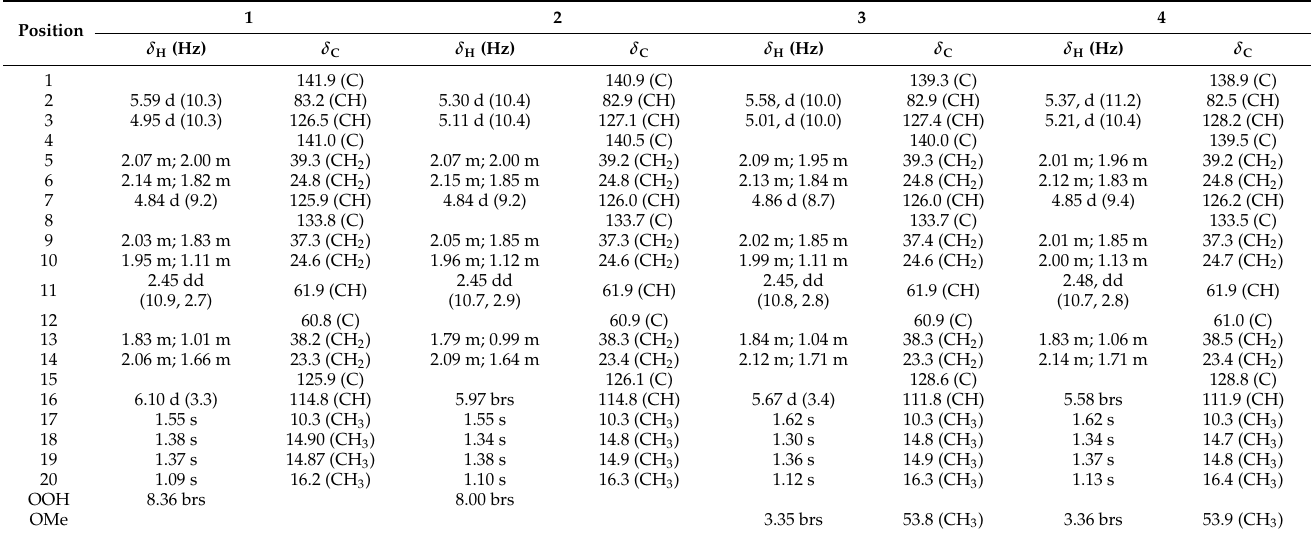
Table 1. 1 H (400 MHz) and 13 C NMR (100 MHz) spectroscopic data of 1 – 4 in C 6 D 6 .